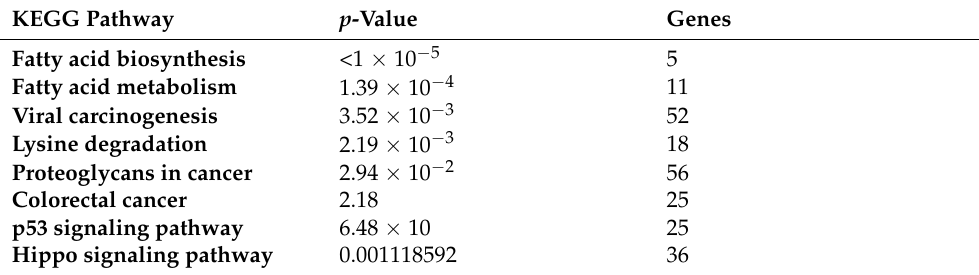
Table 2. Biological pathways enriched by differentially expressed serum miRNAs in ASSD-ILD patients compared to no-ILD patients.